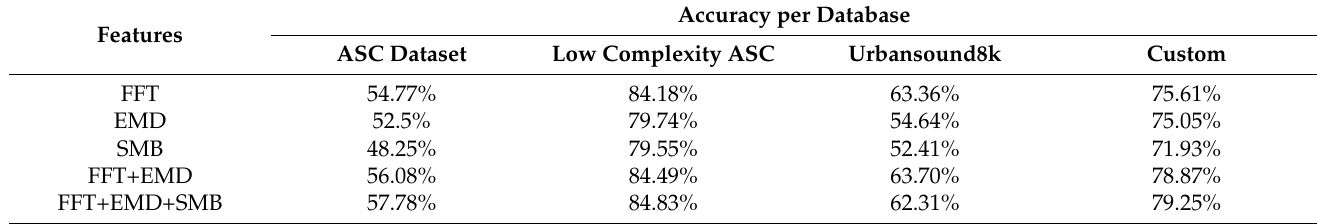
Table 2. System performance comparison.